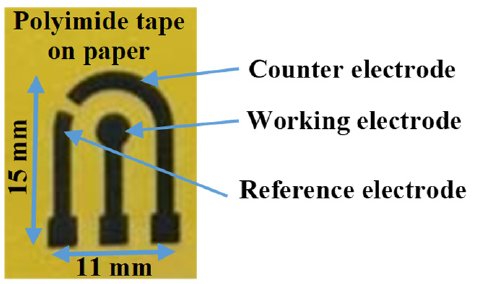
Figure 1. LIG 3-electrode system on polyimide tape fabricated by laser inscribing.